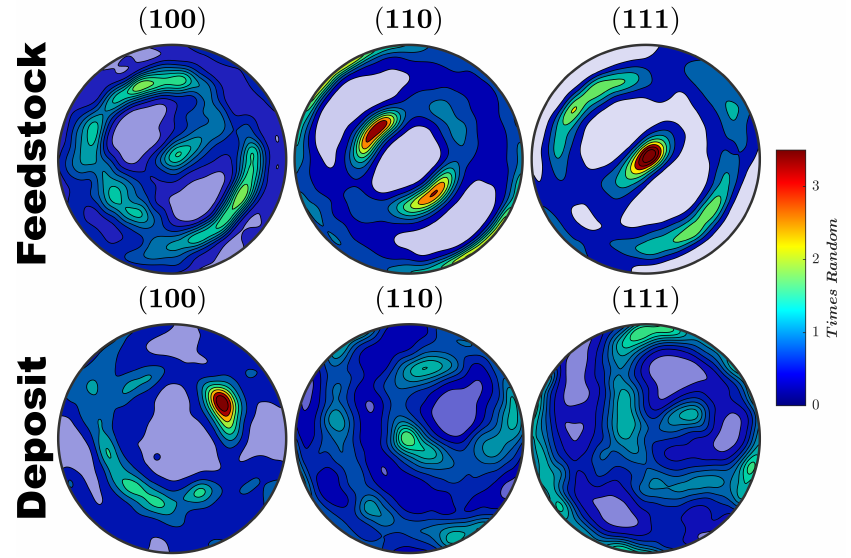
Figure 6. Pole figures for the feedstock and the deposit, as determined by electron back-scatter